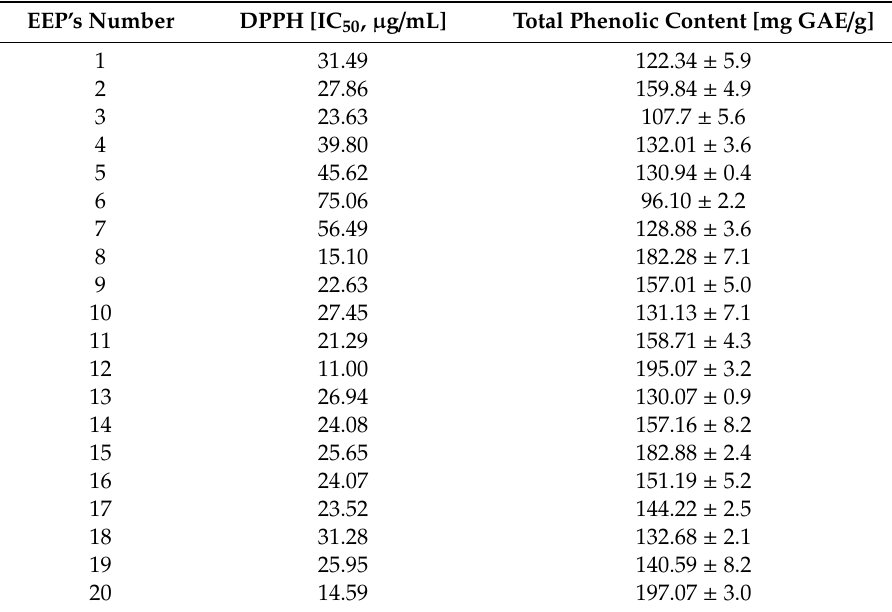
Table 4. Antioxidant activity of EEPs and total phenolic